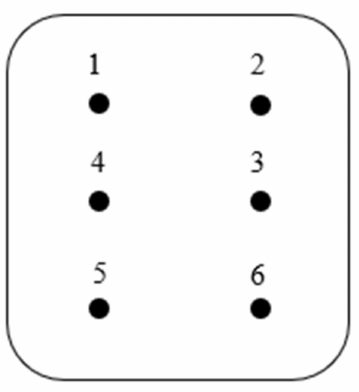
Figure 1. Shot sequence: 1 ÷ 6 shots at an angle of 0 ± 5 ◦